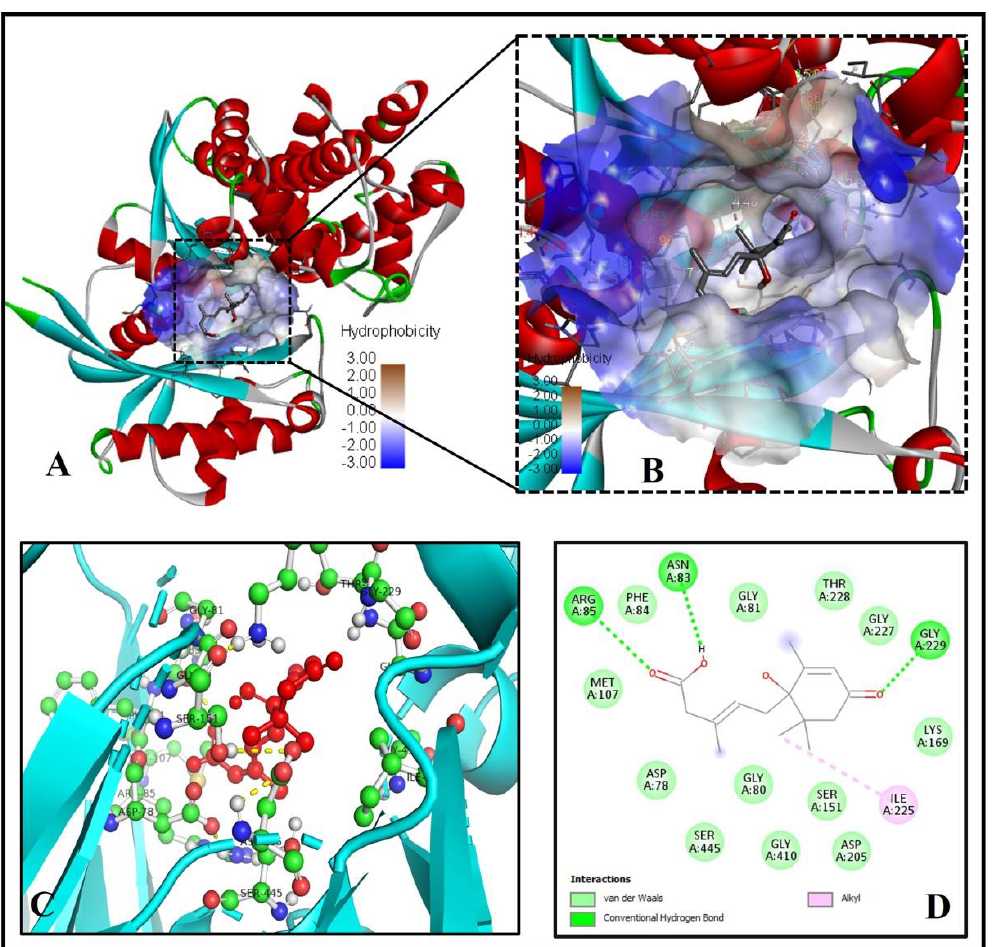
Figure 6. Human glucokinase (PDB ID- 4IXC) is docked with ABA. ( A ) ABA binds the catalytic site. ( B ) An enlarged image of the hydrophobicity of the binding cavity’s amino acid residues ( C ) The 3D picture reveals substantial interactions (yellow dashed lines with bond length) of ABA (red ball and sticks) with human glucokinase residues (green ball and sticks). ( D ) The molecular level interactions of binding pocket residues with ABA are depicted in the 2D plot.